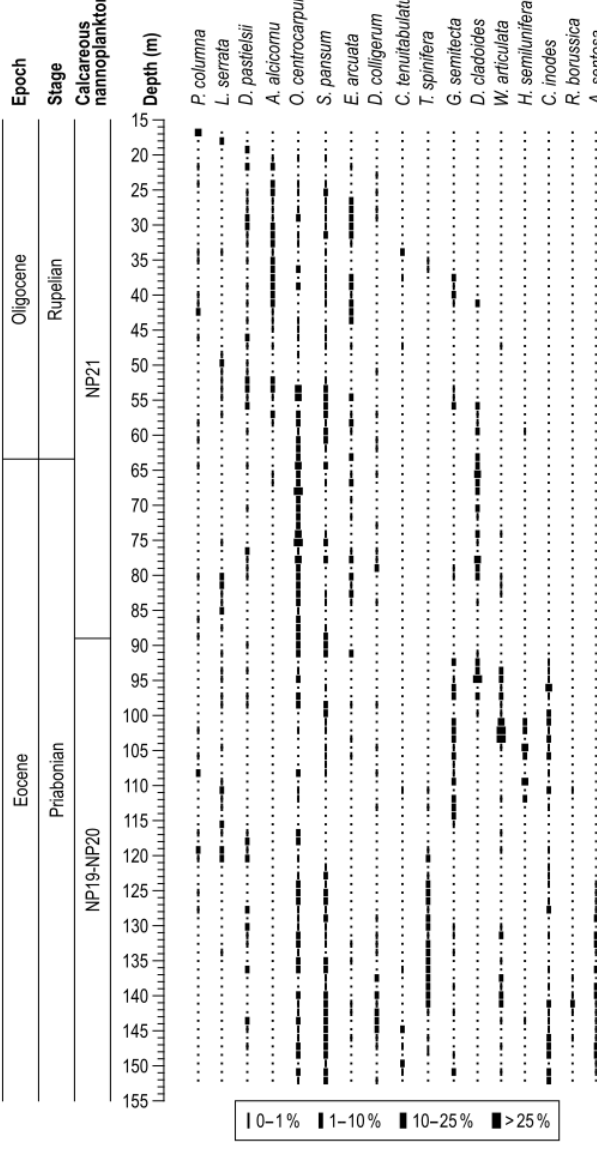
Figure 4. Semiquantitative range chart of dinocyst taxa encoun- tered at the Mossy Grove core, central Mississippi, US Gulf Coastal Plain, including calcareous nannoplankton